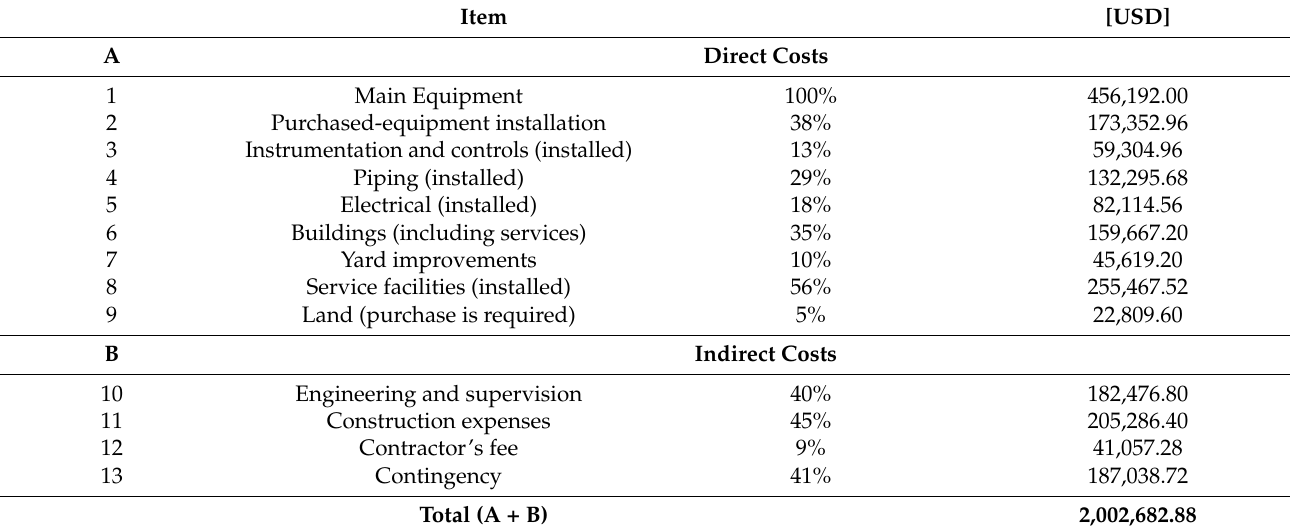
Table 6. Total Capex for the Cases A and B, calculated using the Peter and Timmerhaus method.